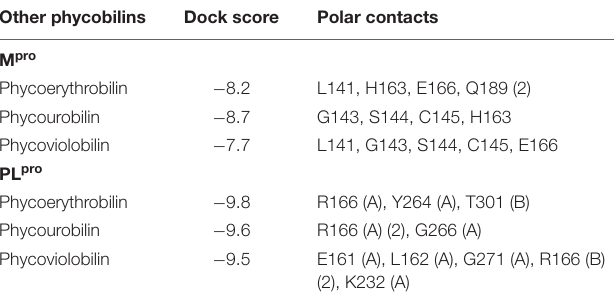
TABLE 4 | Molecular docking results of phycocyanobilin with proteases of other pathogenic human and animal CoVs. CoVs PDB ID Dock score